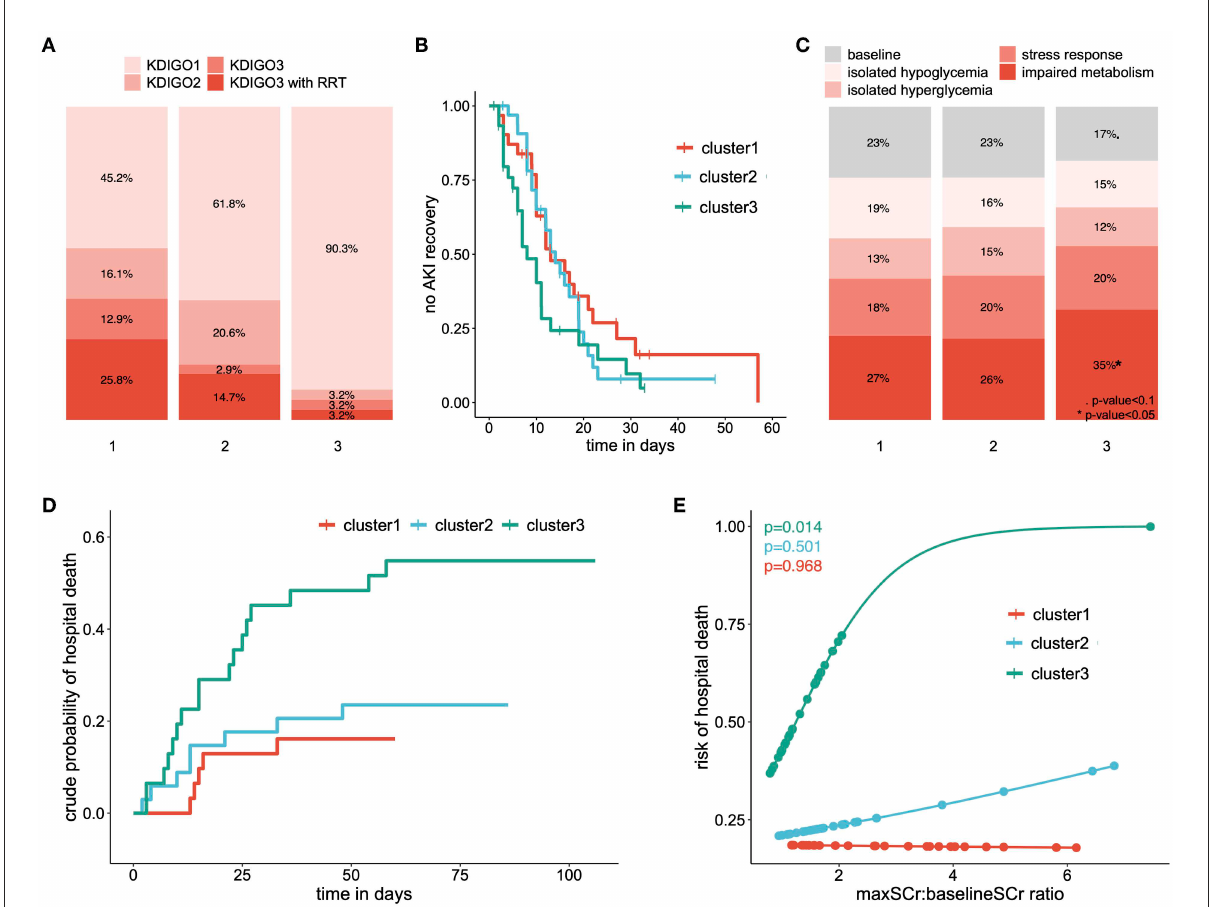
FIGURE3 Clinical outcomes of each cluster: (A) repartition of AKI severity among clusters, according to the KDIGO criteria (B) survival curve showing the proportion of patients who did not experience AKI recovery, over time and among clusters, (C) relative time spent in each metabolic pattern according to clusters of AKI patients, (D) cumulative incidence curve of the hospital mortality, stratified on clusters of AKI patients and (E) predicted risk of hospital death according to the ratio of maximal and baseline serum creatinine level among clusters. eGFR estimated Glomerular Filtration Rate; RRT Renal Replacement Therapy. p -value < 0.1; * p -value < 0.05; ** p -value < 0.001; *** p -value <